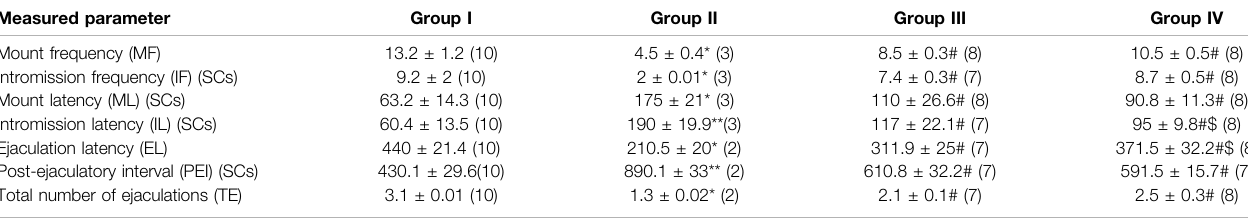
TABLE 1 | Parameters of the copulatory functions (mean ± SD) of the rats of all groups. Measured